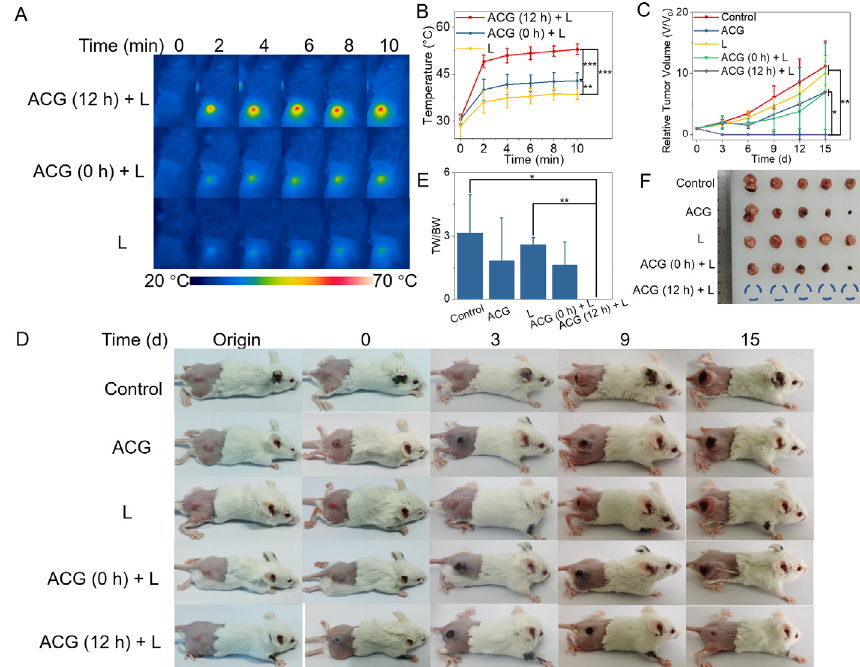
Figure 5. In vivo PTT assisted by the “parasitism” of ACG hydrogel in the tumor. ( A ) Infrared ther- mal photos of tumor-bearing mice during 808 nm laser irradiation, n = 5. ( B ) The average temperature change curves of mice’s tumor surface during 808 nm laser irradiation, shown as means ± SD, complied with the normal distribution and evaluated by one-way ANOVA tests, ** p < 0.01, *** p < 0.001. ( C ) The average relative tumor volume (V/V 0 ) change of mice in each group, shown as means ± SD, complied with the normal distribution and evaluated by one-way ANOVA tests, * p < 0.05, ** p < 0.01. ( D ) The digital photographs of tumor-bearing mice at different time points (Origin, 0, 3, 9, and 15 d) in each group, n = 5. ( E ) The ratio of tumor weight to body weight of mice in each group, shown as means ± SD, not complied with the normal distribution and evaluated by nonparametric Kruskal–Wallis tests, * p < 0.05, ** p < 0.01. ( F ) Photo of tumor masses excised from tumor-bearing mice after different treatments. ACG: intratumoral injection of 50 μ L ACG hydrogel. L: 808 nm laser irradiation (2 W/cm 2 , 10 min). ACG (0 h) + L: intratumoral injection of 50 μ L ACG hydrogel followed by immediate laser irradiation (2 W/cm 2 , 10 min). ACG (12 h) + L: intratumoral injection of 50 μ L ACG hydrogel followed by 12 h delayed laser irradiation (2 W/cm 2 , 10 min). TW: Tumor Weight. BW: Body